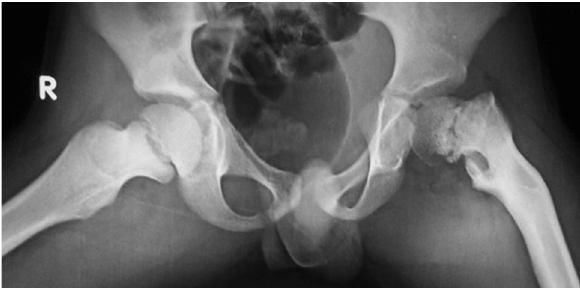
Fig. 2 A standard frog-leg lateral radiograph of the pelvis and both hip joints showed a dysplastic proximal femur and acetabulum with a retroverted neck on the affected side